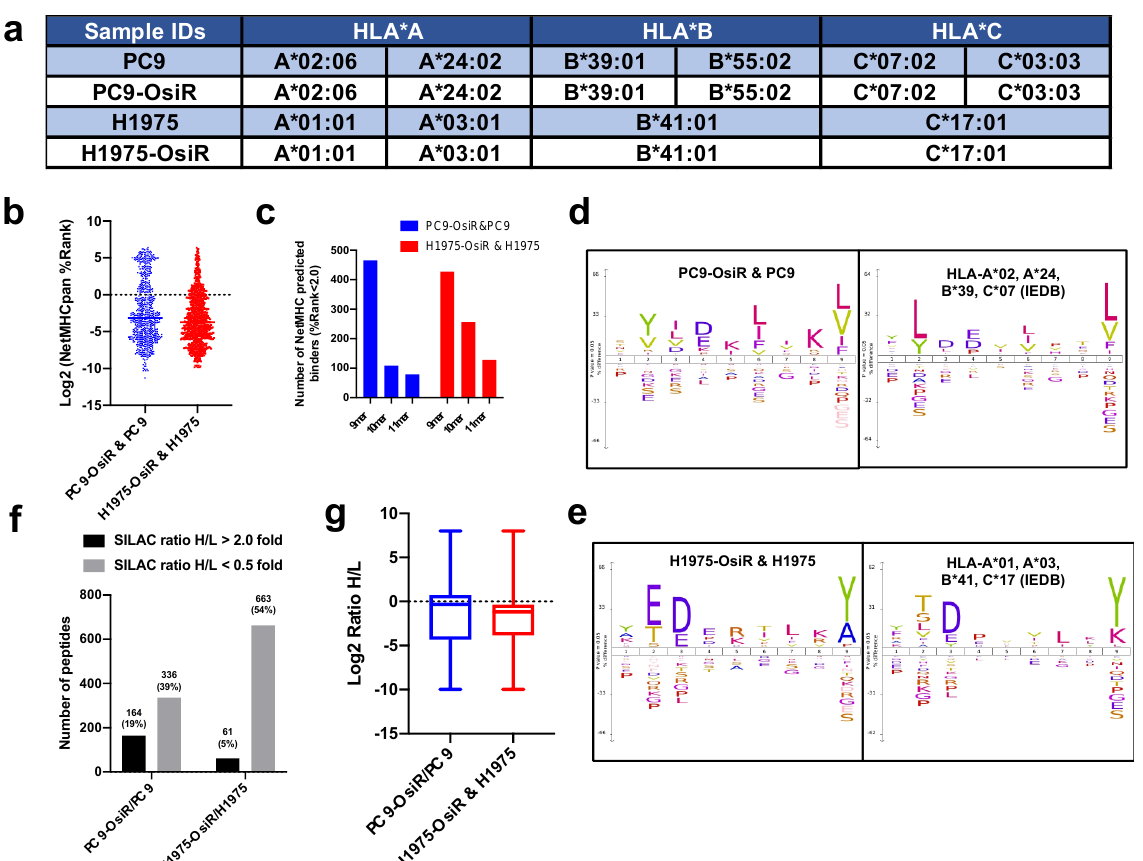
( f ) Schematic of discovery pipeline of SILAC quantified HLA class I-presented peptides (upper panel) and summary table of the number of peptides after each step of filtering (lower panel). ( g ) Upper panel: an example of SILAC labeled HLA immunopeptide, PDIA3-derived peptide, YGVSGYPTLK (*) with a heavy labeled lysine (lys8), displays the light (osimertinib-sensitive) and heavy (osimertinib-resistant) peaks in a MS full scan, where monoisotopic peak (2+ charged) shows 4Da difference m/z ratio (8Da divided by charge. Lower panel: extracted ion chromatography (XICs) of both light and heavy peptides of YGVSGYPTLK shows a ratio H/L = 0.71, indicating this peptide abundance is reduced by 1.4-fold in the OsiR cells. ( h , i ) Peptide length distribution of the identified HLA immunopeptides in 4 biological replicates in PC9-OsiR/PC9 cells ( h ) and H1975-OsiR/H1975 cells ( i ). ( j ) SILAC labeling position (lys and/or arg) distribution in the identified 9 mer peptides in both cell lines.